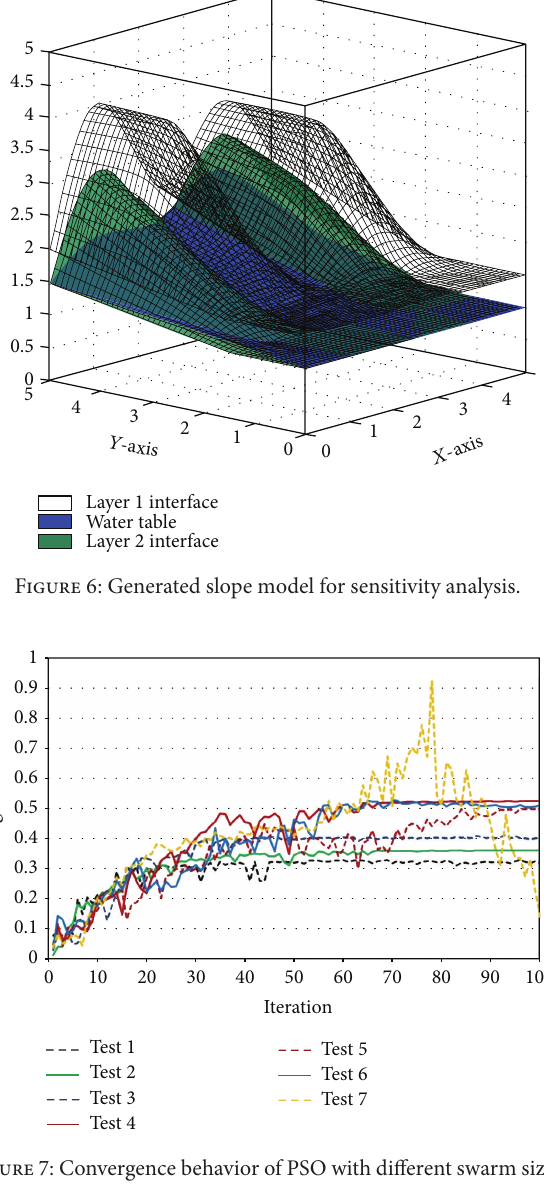
Table 1: Properties of slope in sensitivity analysis.